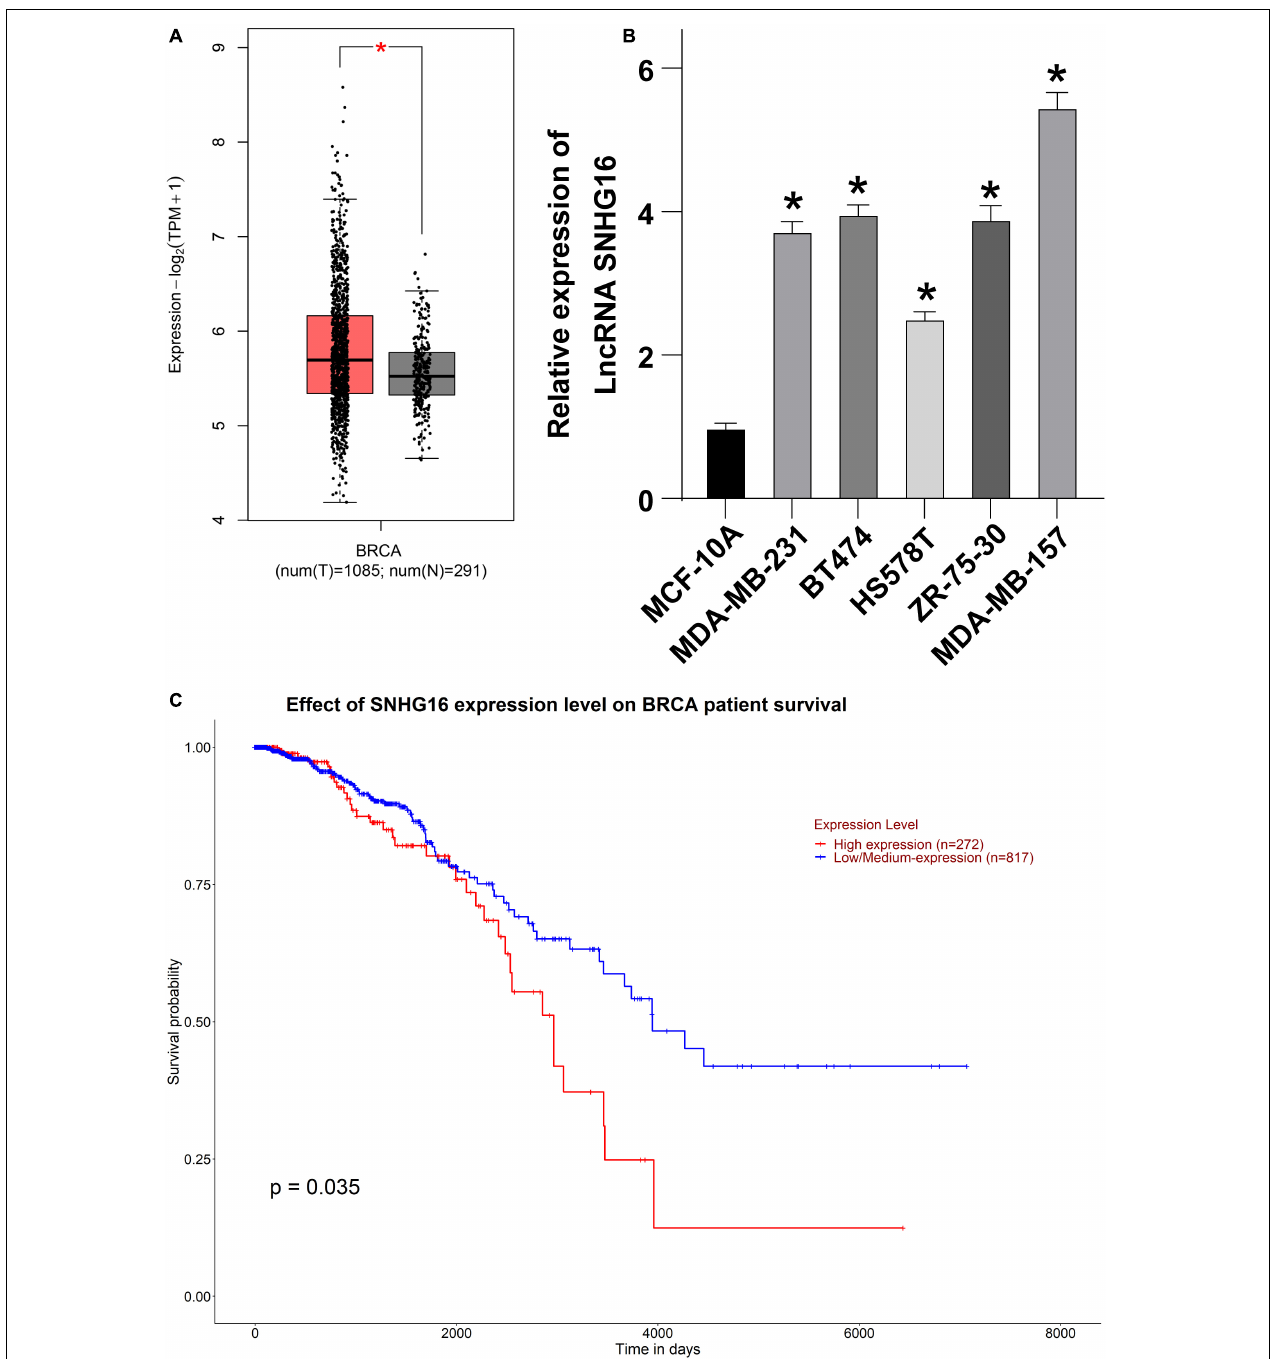
FIGURE 1 | LncRNA SNHG16 was upregulated in BC samples and cells. (A) The differential expression of lncRNA SNHG16 in BC samples and normal samples collected by TCGA and GTEX databases. The abscissa represents the sample type and the ordinate represents the expression of SNHG16; the red box diagram represents the BC samples and the gray box diagram represents the normal samples, * p < 0.05. (B) The expression of SNHG16 in BC cell lines and immortalized breast epithelial cell line was detected using RT-qPCR. (C) The survival analysis of SNHG16 in BC patients from UALCAN cancer database. Cell experiment was repeated three times. Data were presented as mean ± standard deviation. Data in B were analyzed using one-way ANOVA, followed by Tukey’s multiple comparison test, * p < 0.05 vs. MCF-10A